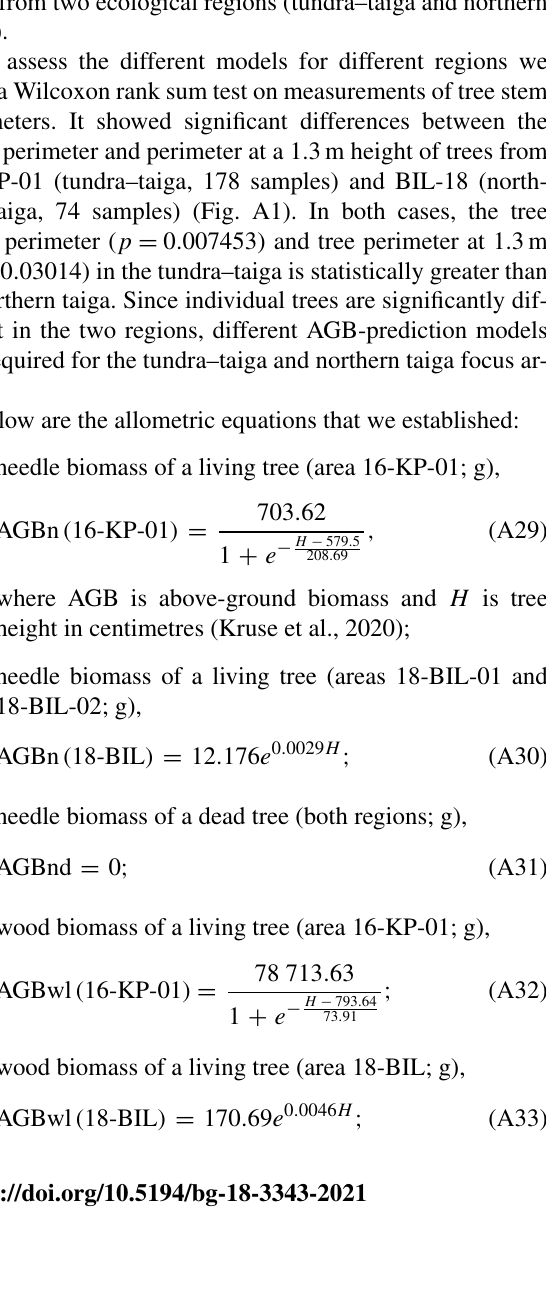
Estimate Standard error t adj